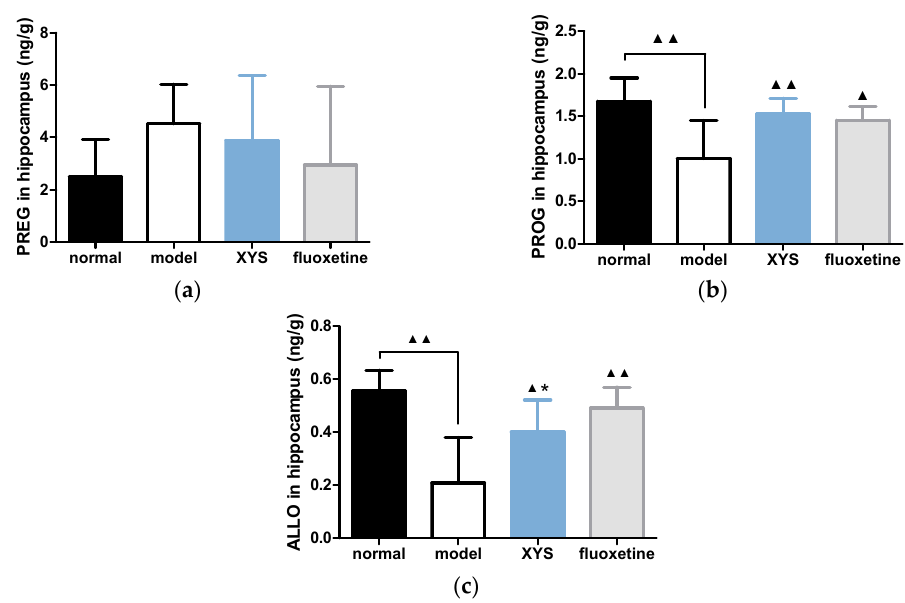
Figure 5. ( a ) PREG content; ( b ) PROG content; ( c ) ALLO content in hippocampus. The data were expressed as mean ± standard deviation ( x ± s), n = 10. ▲ p < 0.05, ▲▲ p < 0.01, compared with the model group; * p < 0.05, compared with the normal group.